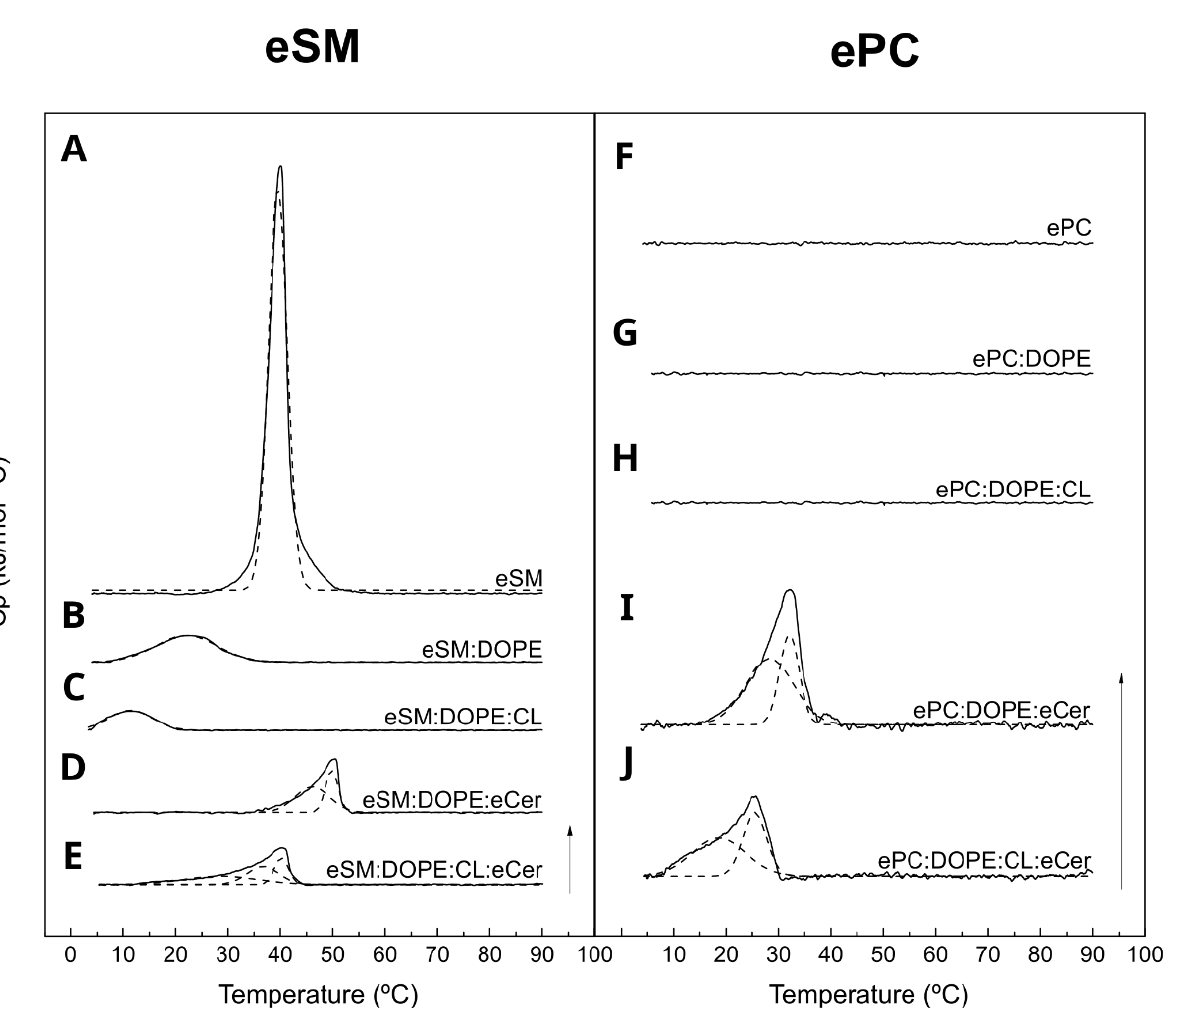
Figure 1. DSC thermograms of lipid mixtures dispersed in excess water. eSM ( A ); eSM:DOPE (50:50) ( B ); eSM:DOPE:CL (33:33:33) ( C ); eSM:DOPE:eCer (40:50:10) ( D ); eSM:DOPE:CL:eCer (23:33:33:10) ( E ); ePC ( F ); ePC:DOPE (50:50) ( G ); ePC:DOPE:CL (33:33:33) ( H ); ePC:DOPE:eCer (40:50:10) ( I ); and ePC:DOPE:CL:eCer (23:33:33:10) ( J ). Representative thermograms of three independent prepara- tions. The dotted lines correspond to Gaussian fittings of the thermograms in solid line. Arrow: 1 kJ/mol °C.